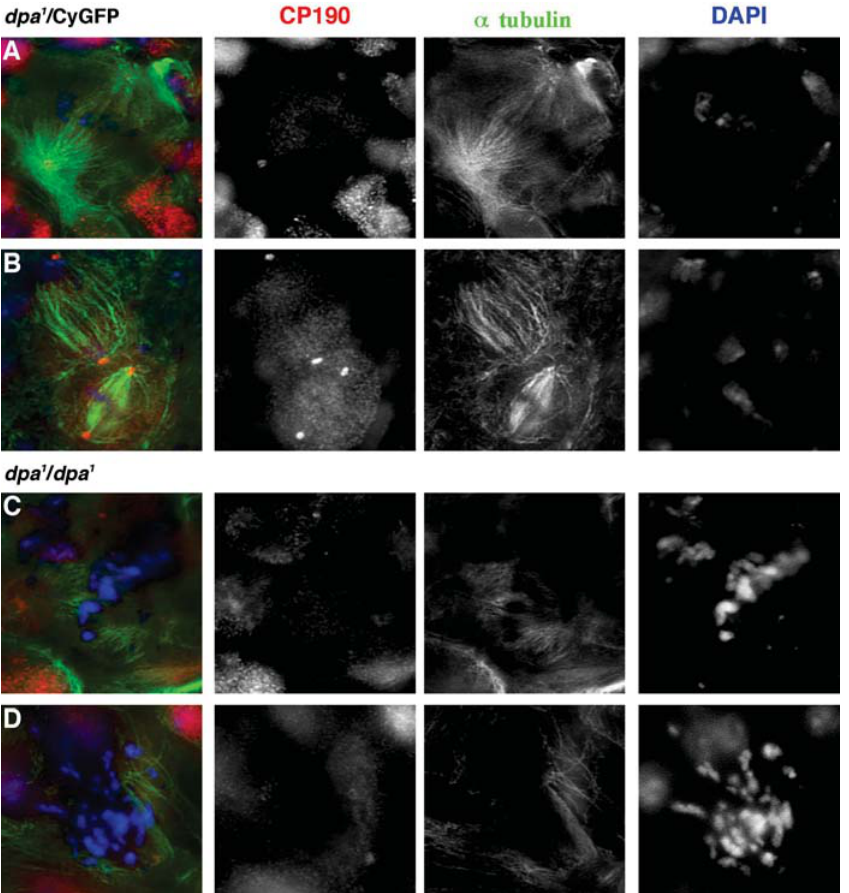
Figure 1. Dpa 1 mutants show abnormal chromosome condensation and unorganised mitotic spindles. Neuroblasts of heterozygous or homozygous third instar larvae (prepared as in 4) were stained for: centrosomes (red) using CP190 antibodies (a kind gift from Will Whitfield) and Goat anti-rabbit TxRed (Jackson labs); spindles (green) using anti-tubulin (Clone DM1A-Sigma) and goat anti-mouse Alexa 488 (Jackson Labs); and DNA (blue) using DAPI (Sigma). Heterozygous neuroblasts showed normal spindles with correct localization of CP190 at the poles in metaphase (A/B) and anaphase (B), and normally condensed chromosomes. Homozygous neuroblasts (C/D) showed fragmented, hyper-condensed and aneuploid chromosomes, and disorganised mitotic spindles usually lacking